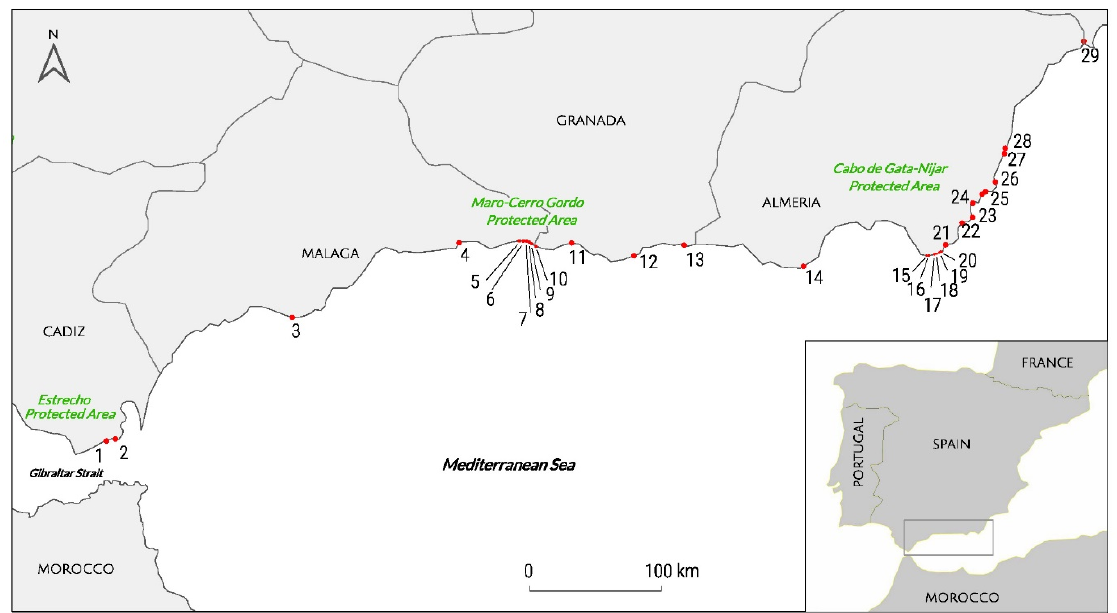
Figure 1. Location of the investigated sites along the Andalusia Mediterranean coast (Spain).